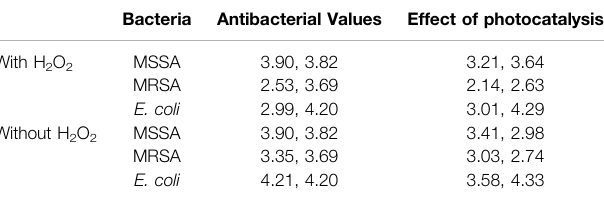
TABLE 1 | The assessment of antibacterial values and effects of photocatalysis according to the ISO 27447 test. Bacteria Antibacterial Values Effect of photocatalysis With H 2 O 2